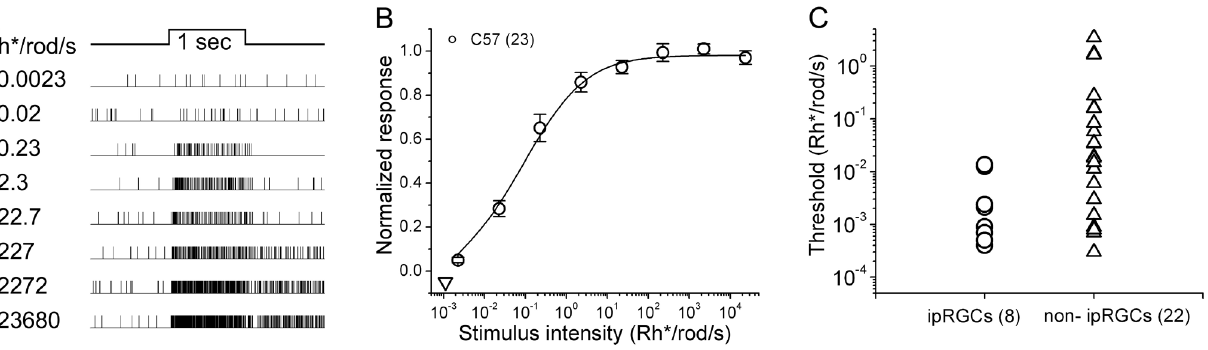
Figure 2. Input from the most sensitive rod pathway to ipRGCs. A : Raster plots of synaptically driven spike responses of a single typical ipRGC in response to a series of flashes increasing in intensity (500 nm; 1 sec). Recordings were extracellular, obtained on a multielectrode array in a dark- adapted wildtype (C57Bl6) mouse retina. B : Irradiance-response curve plotted in semi-log coordinates and based on data averaged from 23 wildtype mouse ipRGCs. For each cell, response amplitude at a given intensity was expressed as the firing rate during that stimulus normalized to the maximal light-evoked firing rate at any intensity. These values were averaged across all cells for each intensity and plotted, with error bars representing the standard error of the mean. The smooth curve represents the Michaelis-Menten fit to these points and the single triangle along the abscissa indicates the response threshold (5% of maximum, calculated from the fit). This irradiance-response profile closely resembles those of ON type RGCs receiving input from the primary rod pathway [50,51]. C : Distribution of the thresholds of the ON responses in ipRGCs (left; n=8) in comparison with those of non-ipRGCs (right; n=22) recorded in the same piece of retina. The thresholds of ipRGCs all located in the lower part of this plot, indicating they are among the most light-sensitive mouse